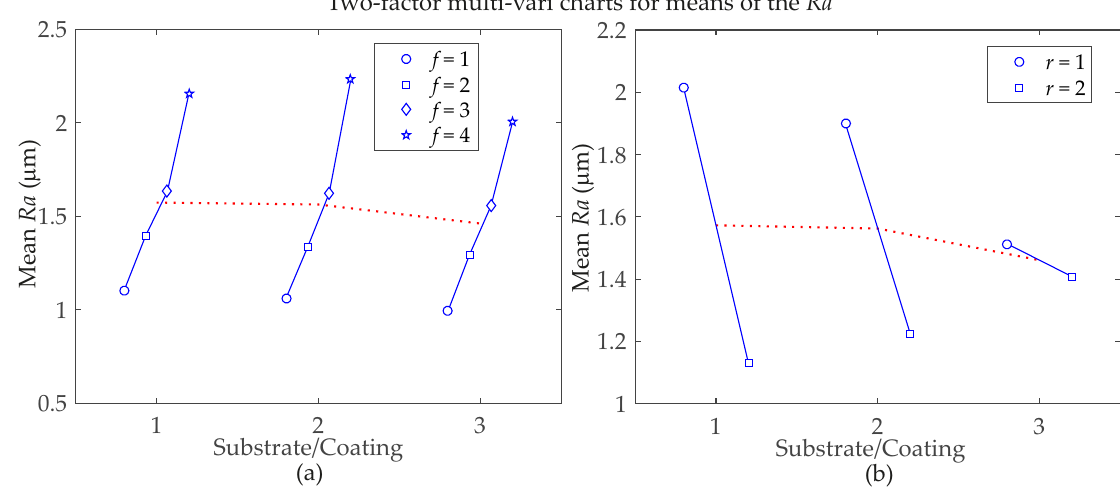
Figure 6. Two-factor multi-variable charts for Ra surface roughness parameter means, considering interactions between: ( a ) Substrate/Coating with feed rate; ( b ) Substrate/Coating with nose radius.